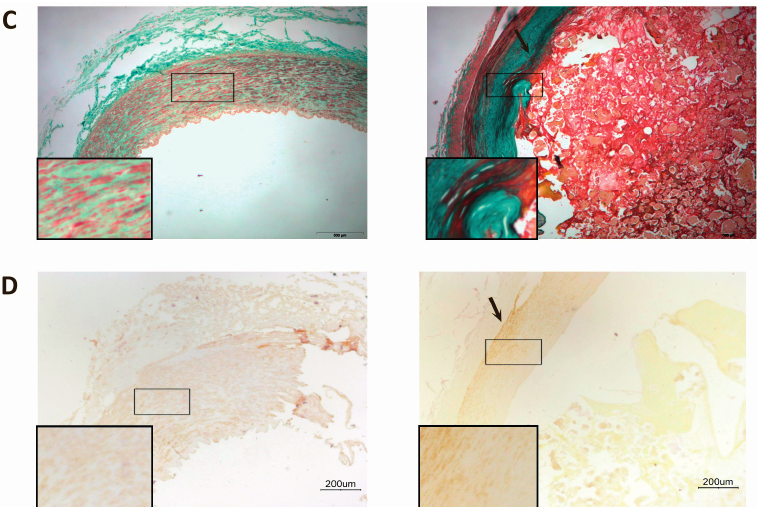
Figure 1. Representative histological images of peripheral arteries: ( A ) Arteries stained with Hematoxylin-Eosin. The intima in affected arteries was thicker and replete with cholesterol deposits and inflammatory cells (arrow). Magnification 20×; ( B ) Alizarin Red staining to detect the presence of calcium. There were calcium deposits in affected arteries located, mainly, in the media and, in some cases, calcium was observed in the internal elastic lamina (arrows). Magnification 20×; ( C ) Masson’s Trichrome stain showing, in affected arteries, an infiltration of smooth muscle cells from the media to the intima (arrow). The lumen shows partial obstruction. Magnification 40×; ( D ) Actin staining to detect the presence of smooth muscle cells. The arrow shows the area of infiltration of these cells from the media to the intima. Magnification 20×. The inserts show higher magnification (100×) images of the indicated